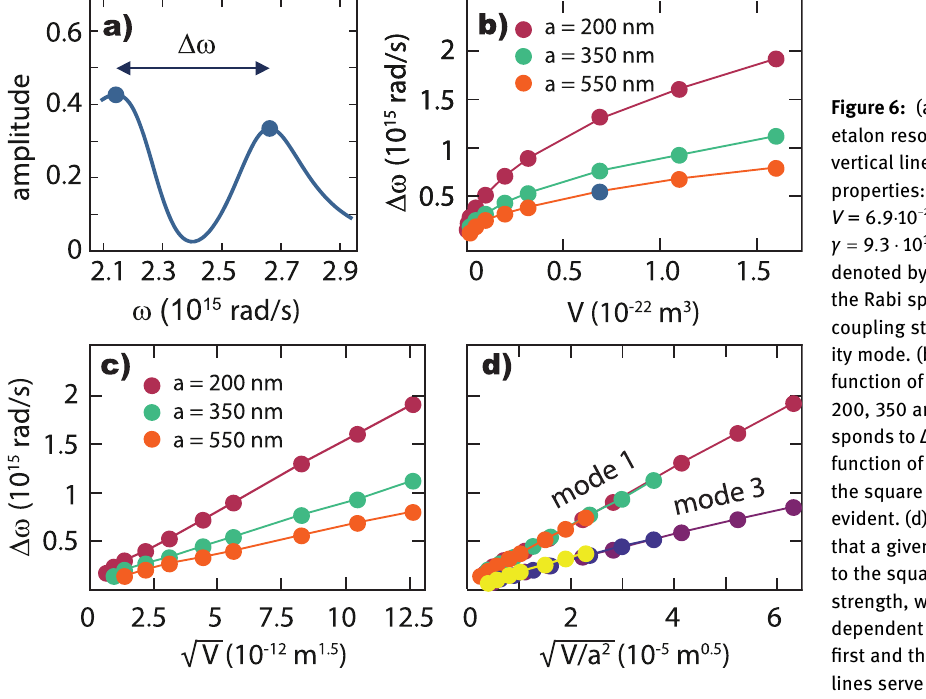
Figure 6: (a) Spectrum at the first order bare- etalon resonant thickness indicated as a vertical line in Figure 5g) (antenna array properties: pitch 550 nm,